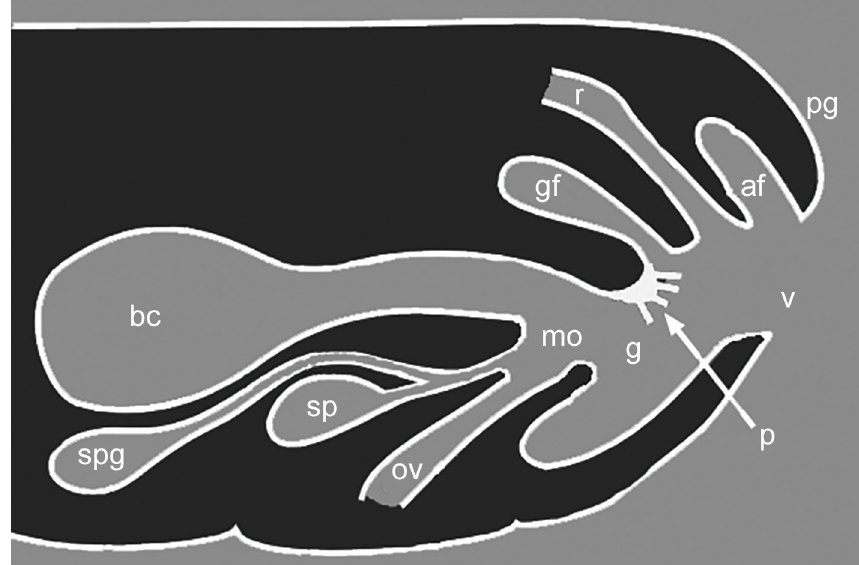
Fig. 1. Outline of the female genitalia of Miridiba Reitter, 1902 in lateral section. Abbreviations: see Material and methods throughout the figure